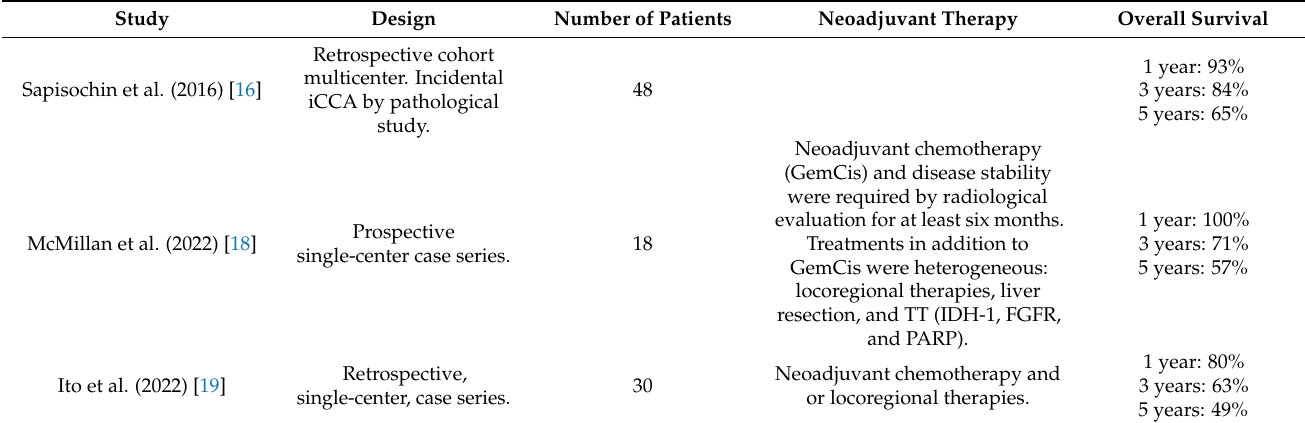
Table 1. Outcomes of LT in patients with unresectable